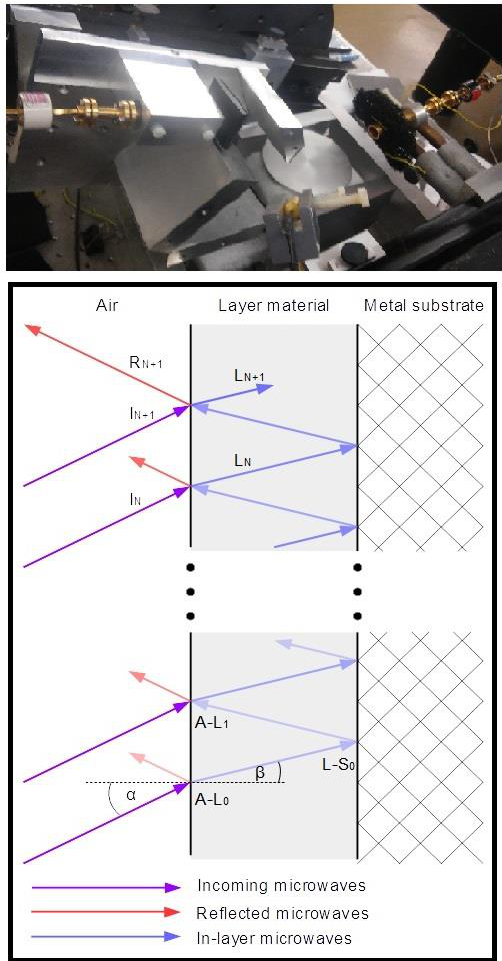
Fig. 2. The measurement setup and a sketch of the